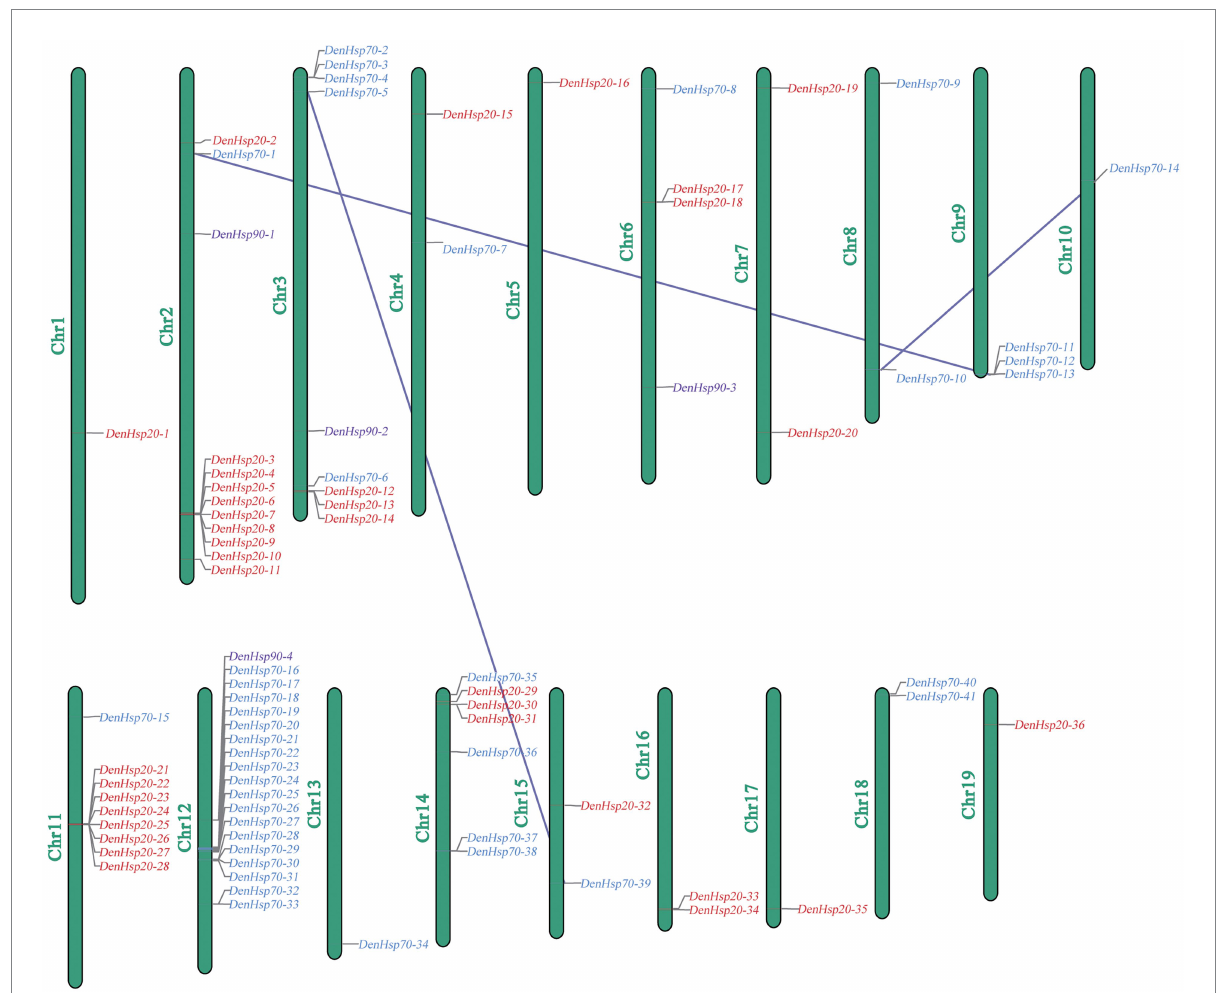
FIGURE 1 Chromosomal distributions of the identified Hsp20 , Hsp70 and Hsp90 genes in Dendrobium officinale . Red, blue, purple colors represent Hsp20 , Hsp70 and Hsp90 genes, respectively. Three lines represent three tandem duplicate pairs.